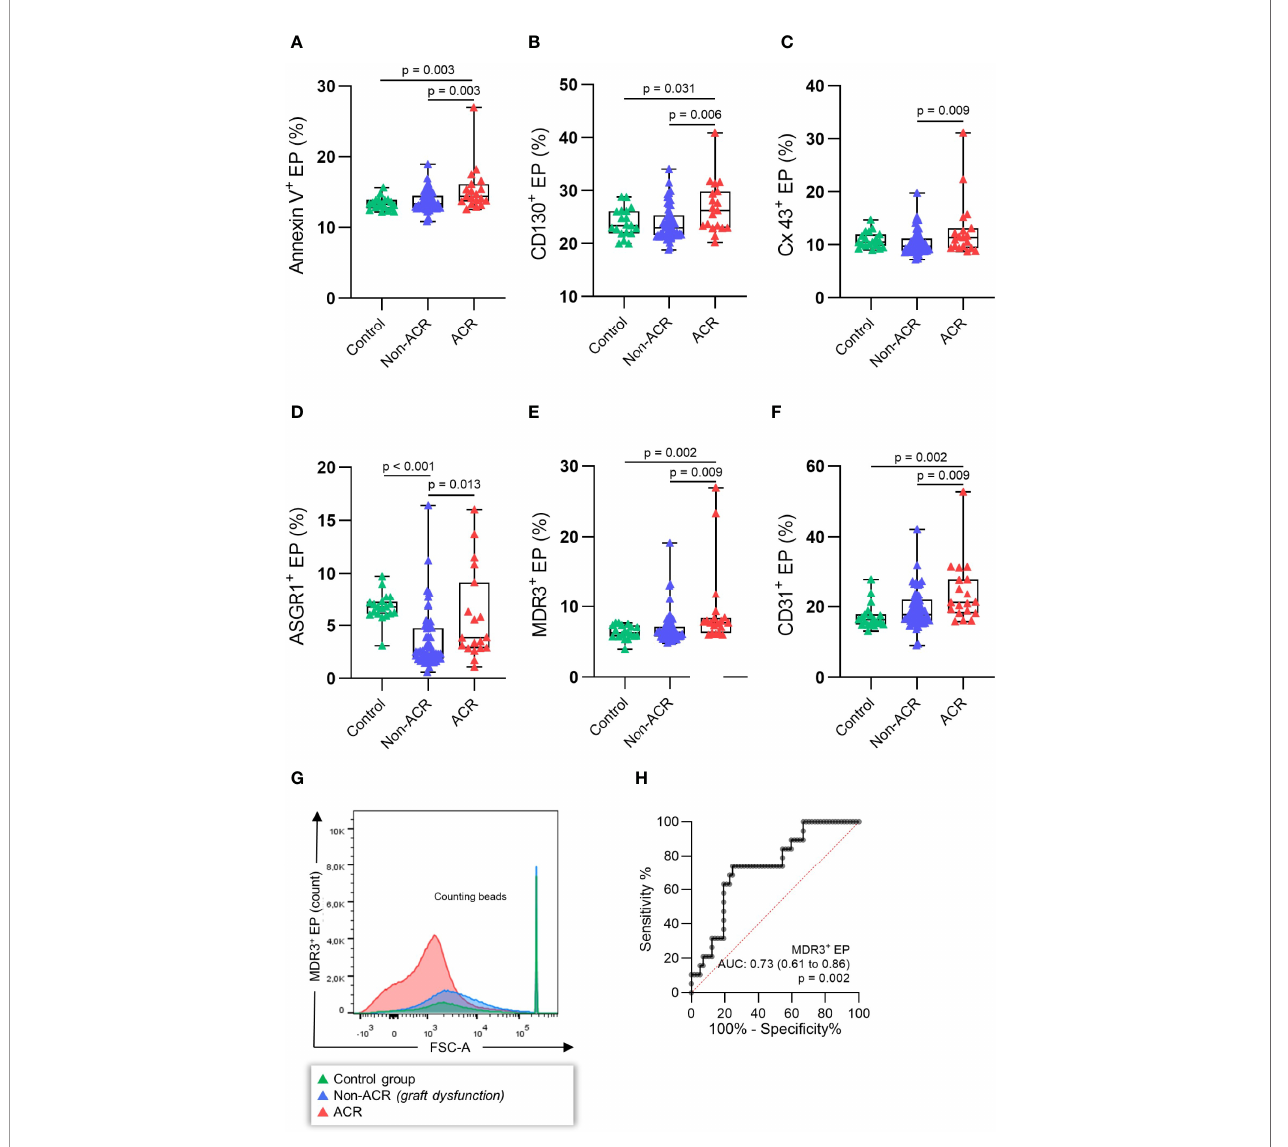
FIGURE 4 | EP pro fi les during histology-proven ACR. EP were determined in the blood plasma of patients with concomitant LBs. The patients were then classi fi ed as histology-proven ACR or non-ACR. EP surface antigens (A) AnnV + , (B) CD130 + , (C) Cx43 + , (D) ASGR1 + , (E) MDR3 + , (F) CD31 + EP were stained, and relative EP (%) were analyzed. (G) Example FSC-A (forward scatter) histograms of MDR3 + EP (%) (H) demonstrating the highest receiver operating characteristic (ROC) of all single antigens. One-way analysis of variance followed by Tukey ’ s post hoc test was used. The plots are indicated by the median, and all error bars indicate the